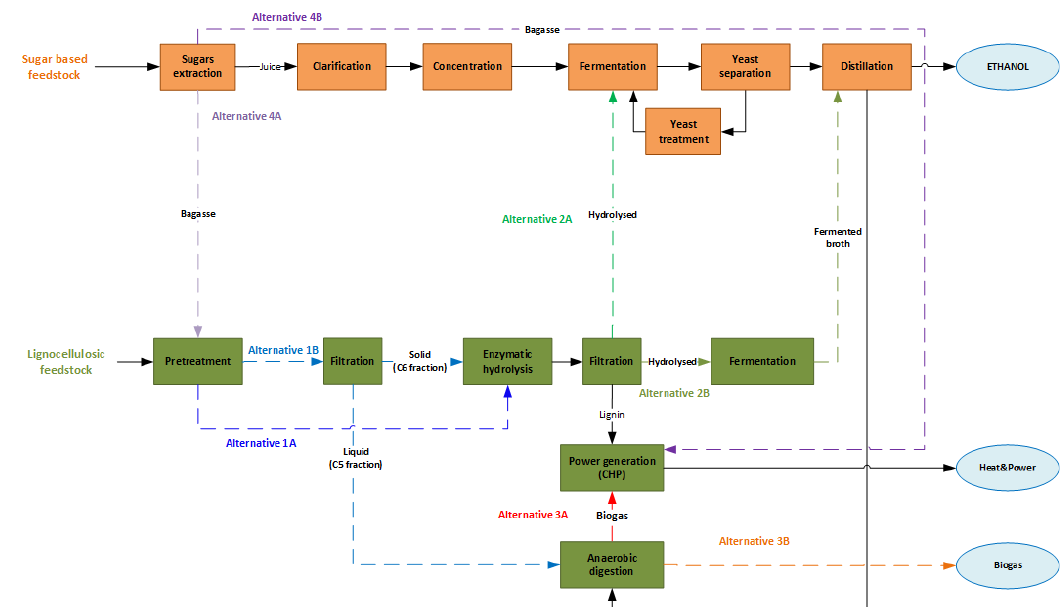
Figure 6. Possible configurations for the retrofitting of a sugar-based 1G facility.